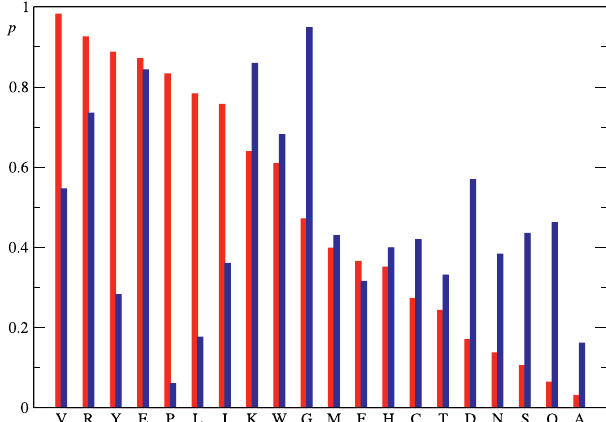
Figure 5. Histogram of the Probability to Find an Amino Acid among 1,000 Combinations of Amino Acids Which Are Most Correlated with OGT for Real Proteomes (Red) and for Artificial Proteomes Created from Reshuffled DNA Sequences (Blue) The histogram for real proteomes supports the stability of IVYWREL predictor, while the difference between the two histograms suggests that amino acid biases upon thermophilic adaptation are not a consequence of the trends in nucleotide composition.